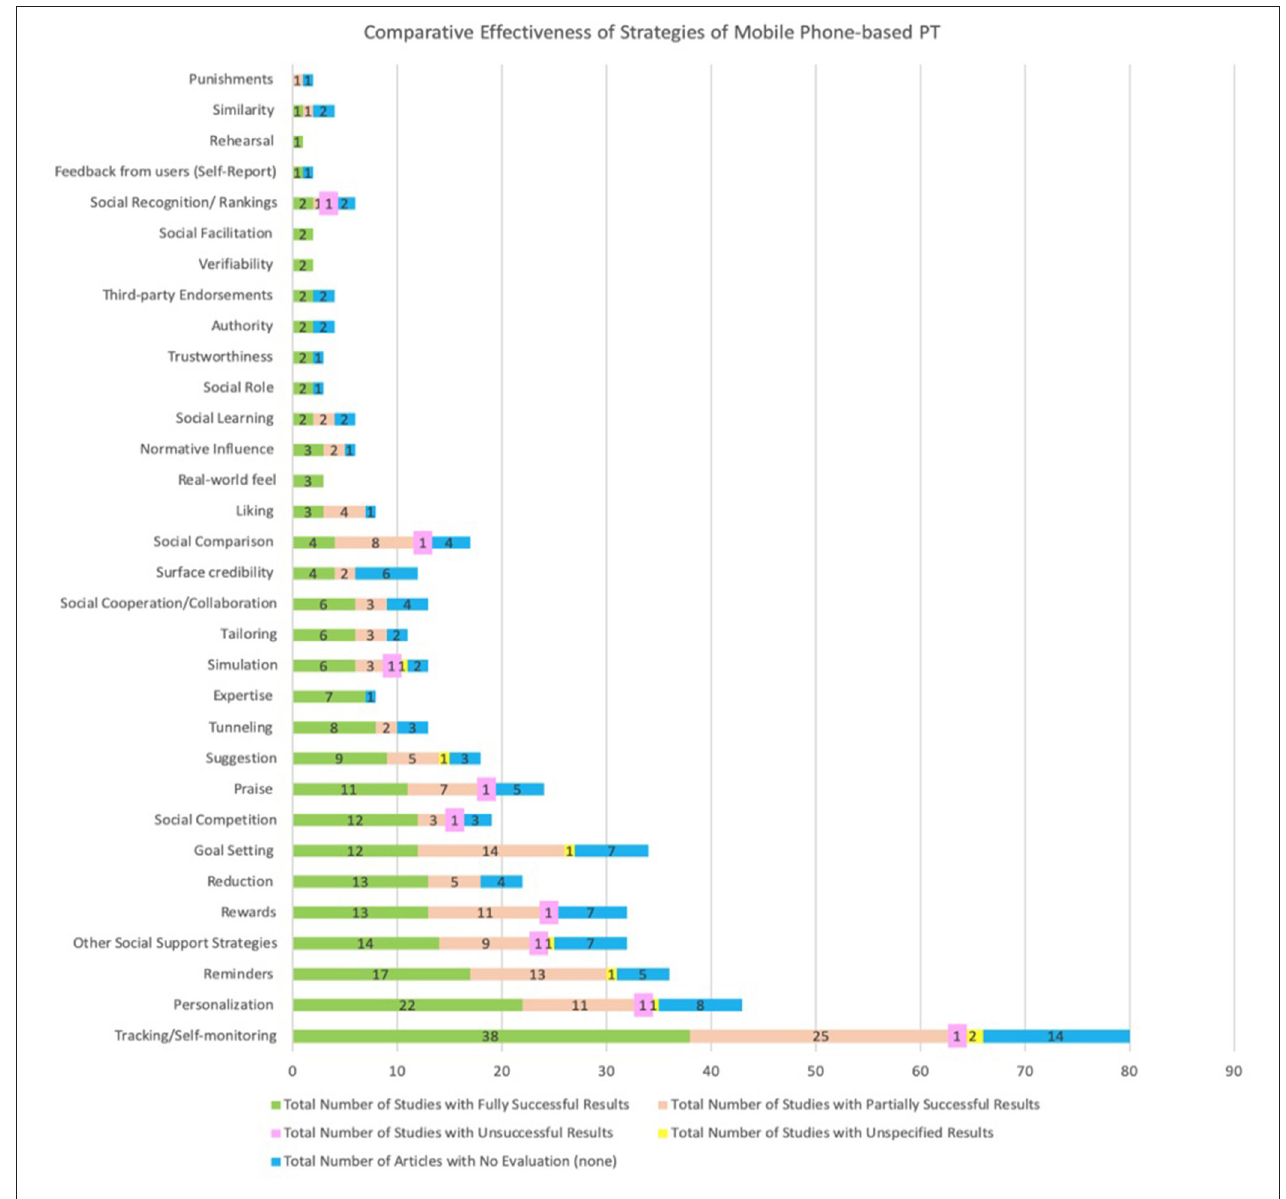
FIGURE 8 | Comparative effectiveness by persuasive strategies.